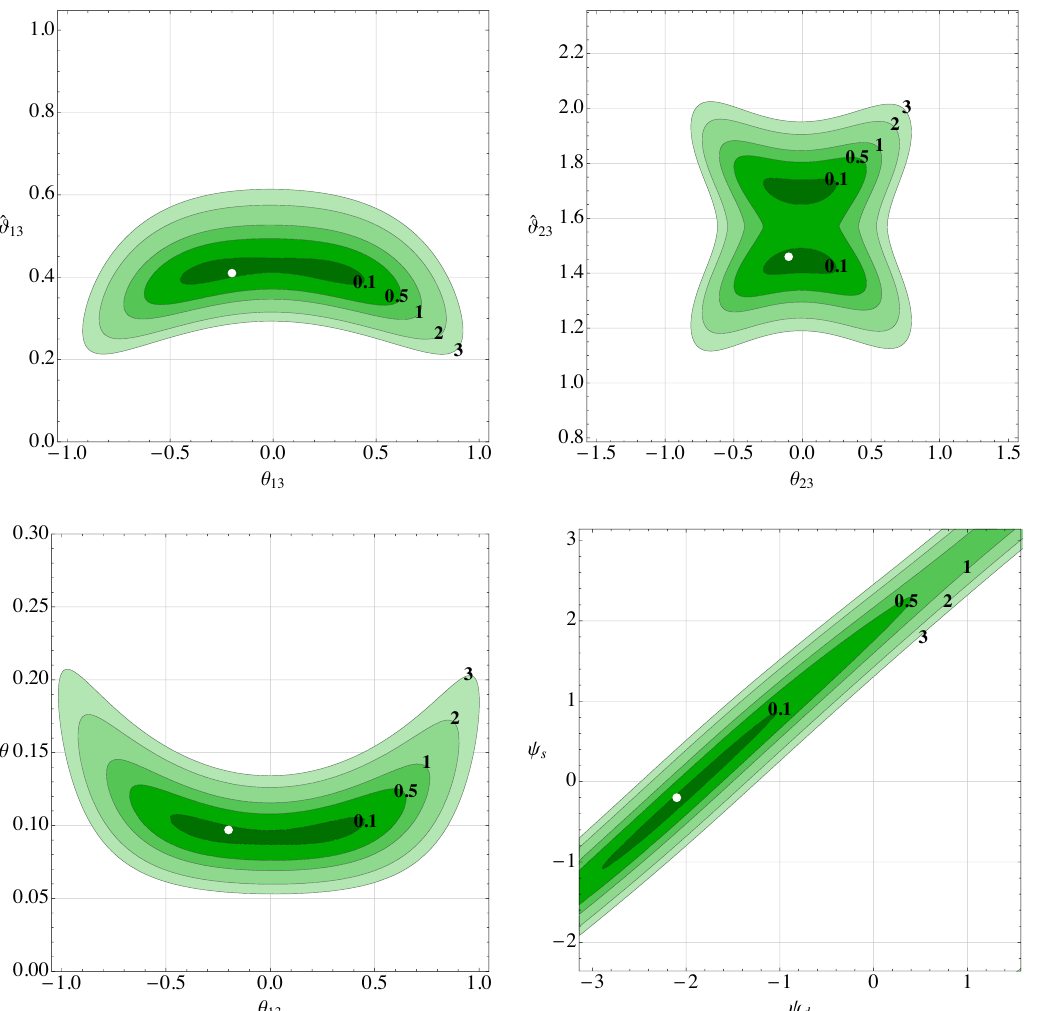
Figure 1 . X 2 = dof regions on various two-dimensional slices of the 1 + 2 (cid:13)avor-locked theory tree parameter space in the neighborhood of the benchmark point (4.4). Contour values are labeled in black; the benchmark point (4.4) is shown by the white